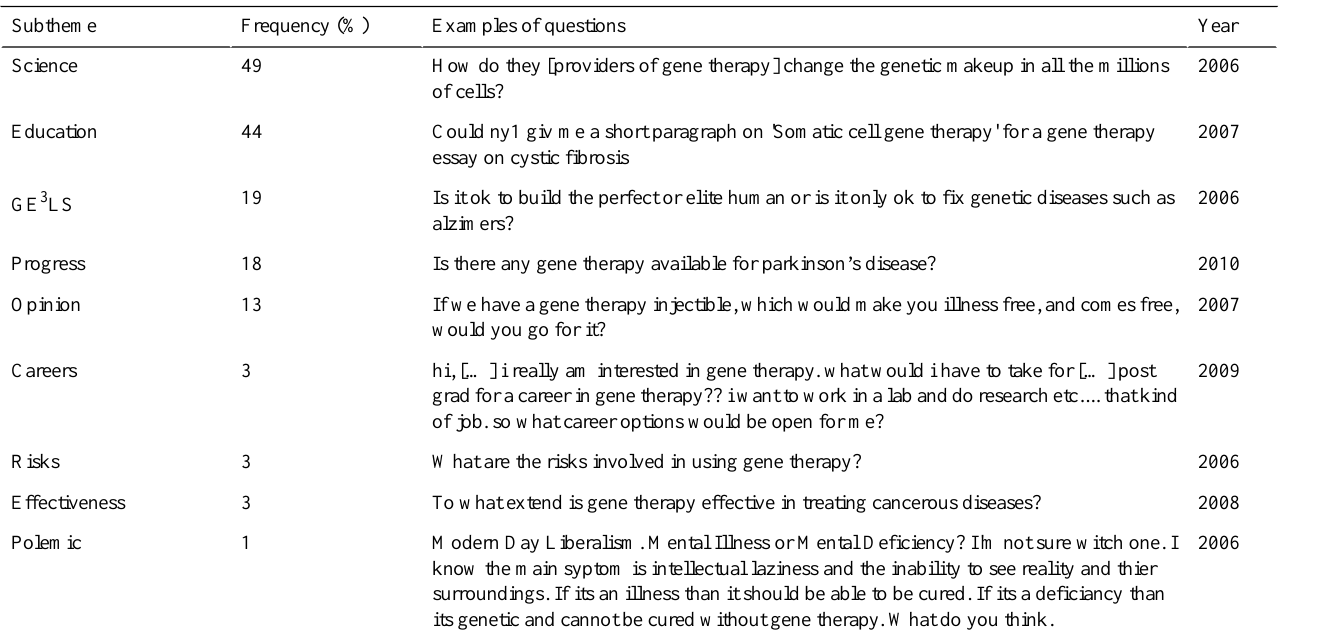
Table 2. Examples of types of